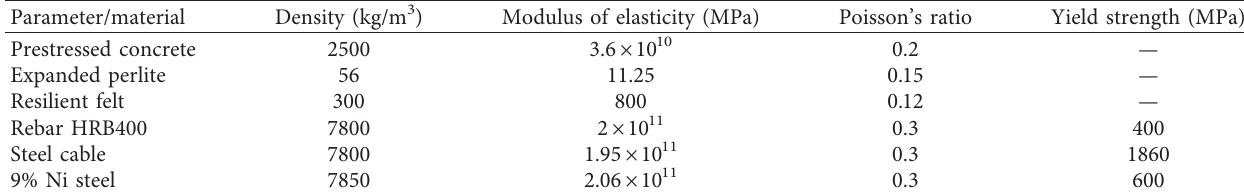
Table 4: Material characteristics of the LNG prestressed storage tank.